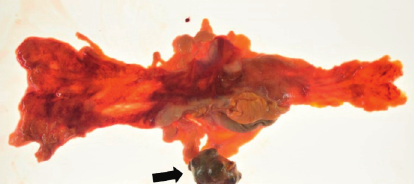
Figure 8: On autopsy, a 40-mm nodule was found in the ileocecal region, and the pathological finding was compatible with GIST. The patient was diagnosed with peritoneal dissemination of